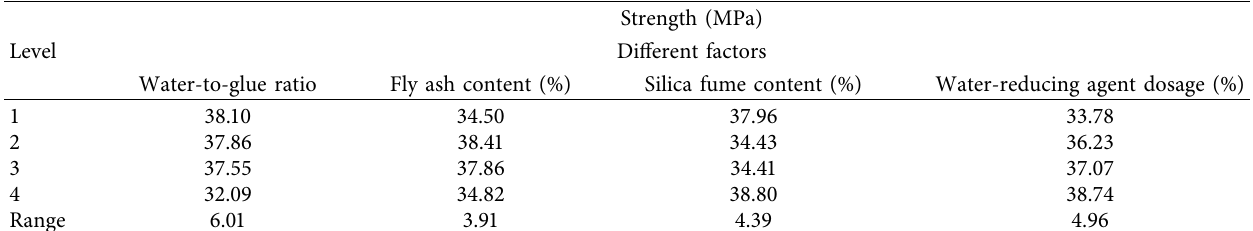
Table 5: Range analysis of 28-day compressive strength of